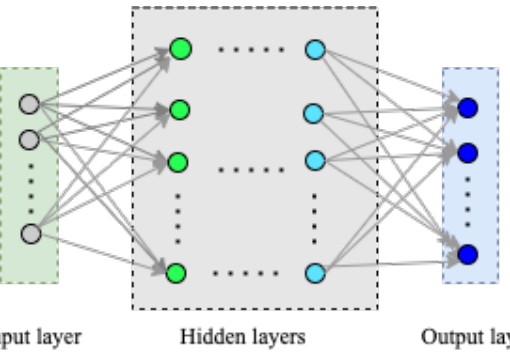
Figure 2. A general architecture of Deep Neural